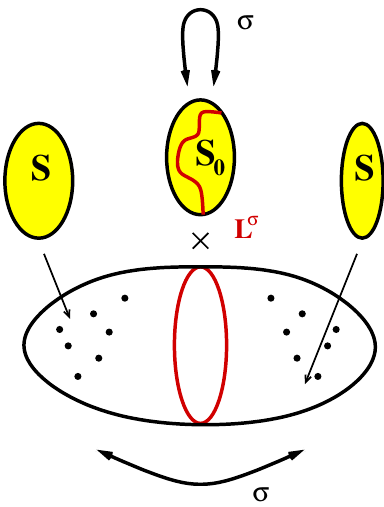
Figure 1 . A cartoon of X and its K3 (cid:12)bration. The anti-holomorphic involution (cid:27) identi(cid:12)es two hemispheres of the base P 1 leaving one great circle (cid:12)xed. This in particular implies that the discriminant locus of the K3 (cid:12)bration is symmetric with respect to this map. Over the (cid:12)xed locus of (cid:27) in the base, (cid:27) acts purely on the K3 (cid:12)bre S 0 as an anti-holomorphic involution such that it keeps the special Lagrangian submanifold L S (cid:12)xed 0